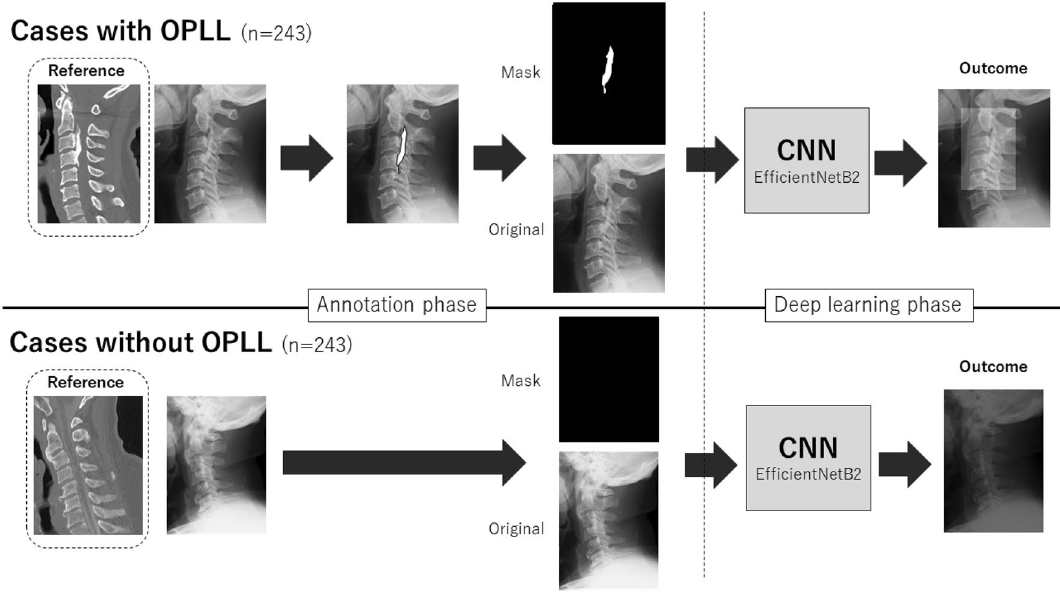
Figure 4. Illustration of study process. Lateral cervical plain radiographies of all patients were extracted as jpeg files from the DICOM database. As annotation phase, an independent researcher manually painted the ossification area in the cases with OPLL on jpeg images of radiography with the reference of CT images. Subsequently, the painted image was divided into mask images for ground truth and original image, and both were used to construct the CNN. In the cases without OPLL on referenced CT image, all-black mask images were created as ground truth for